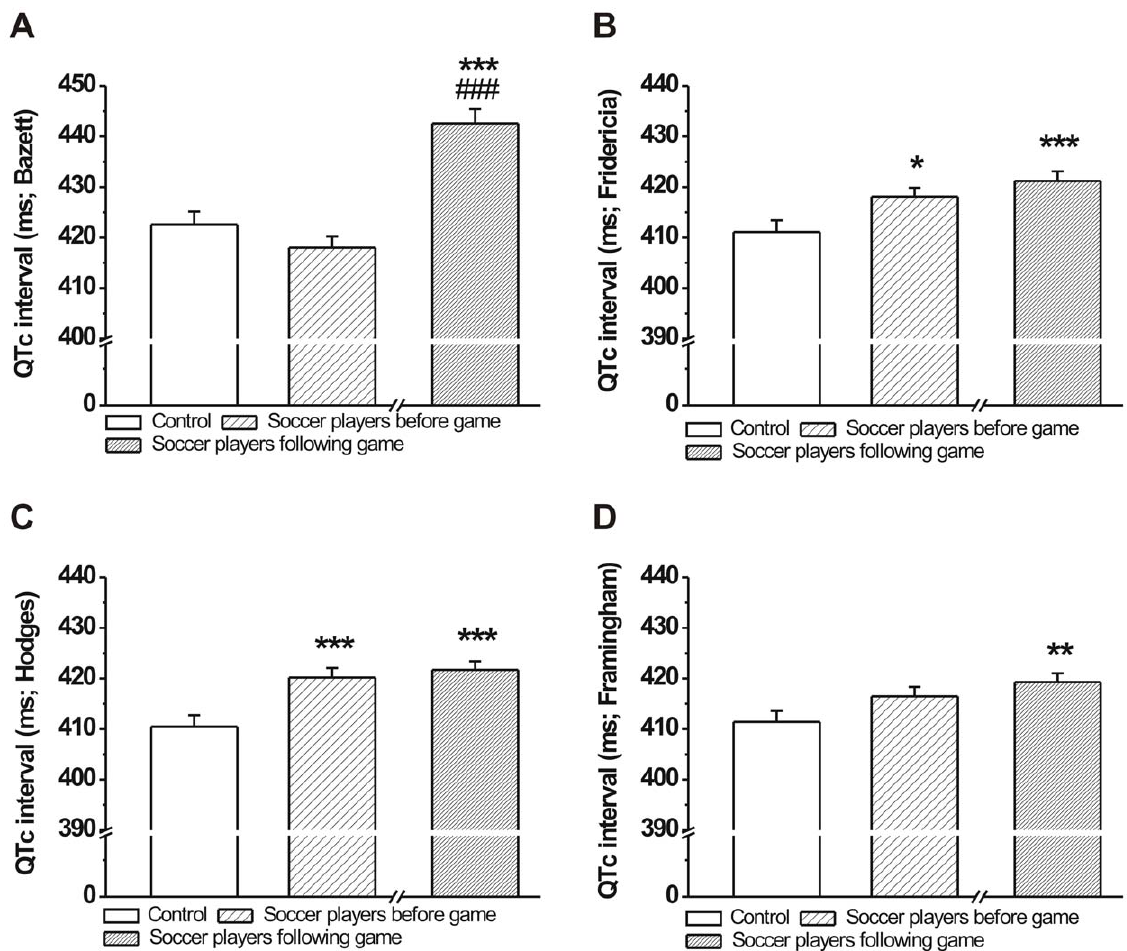
Figure 3. Frequency corrected QT interval of age-matched controls and professional soccer players before and following a competitive game. QTc interval calculated with the Bazett formula was not different in soccer players before the game and was significantly prolonged after the game ( A ). QTc values calculated with the Fridericia and Hodges formulae but not the Framingham formula showed significant difference between groups before the game, and none of the three calculations yielded any difference between before and after game values in soccer players ( B , C and D ; n=76 persons/group; Means 6 S.E.M.; *p , 0.05; **p , 0.01; ***p , 0.001 vs. age-matched control; ### p , 0.001 vs. before game